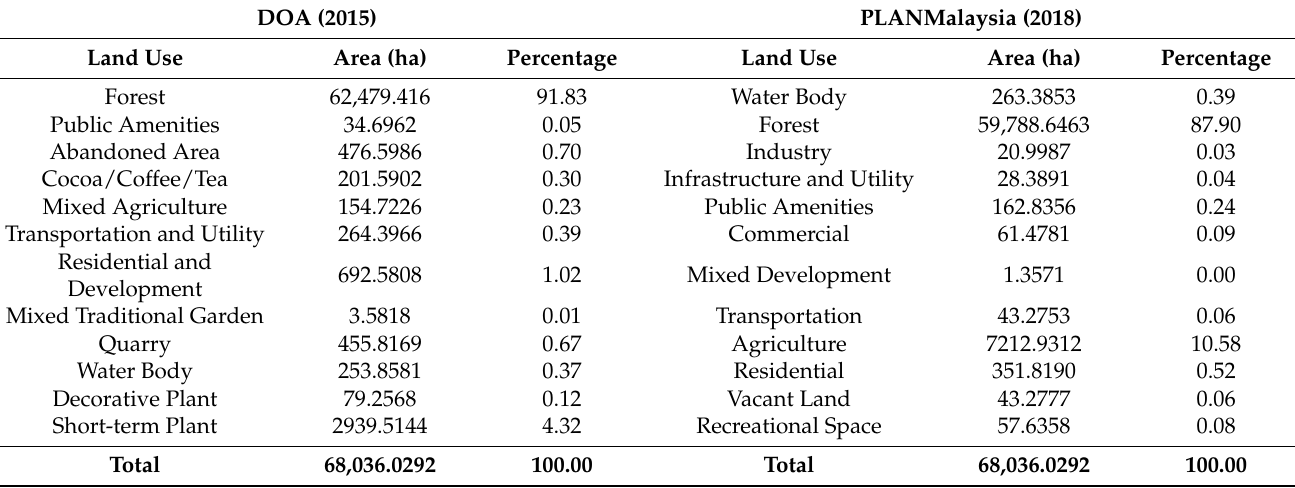
Table 1. Area for each land-use activities in Cameron